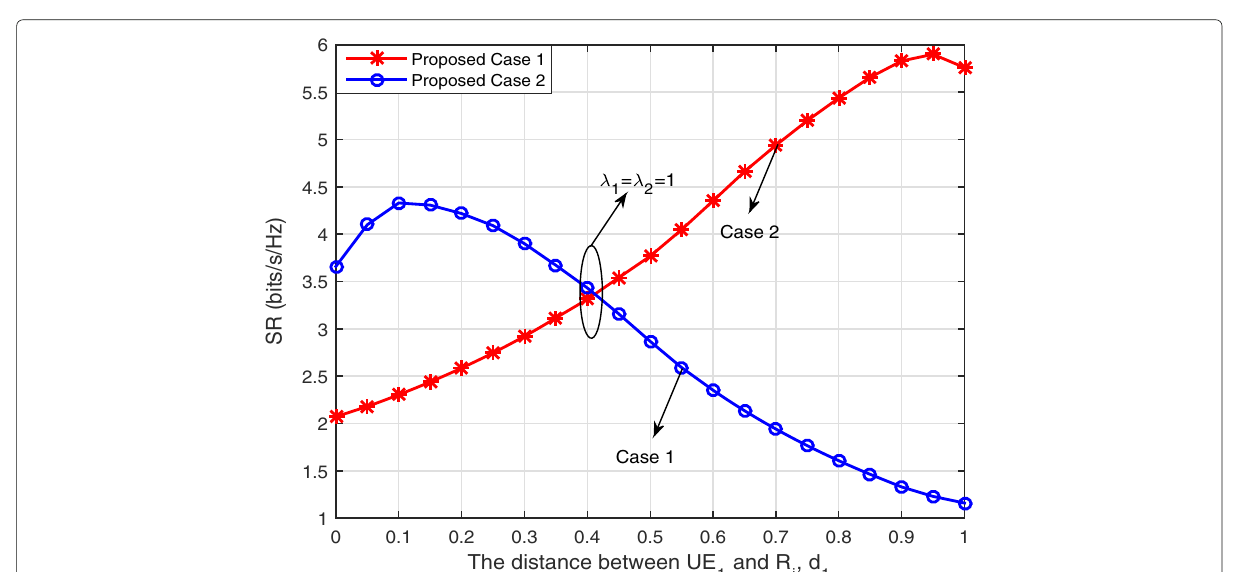
Fig. 5 The achievable weighted SR versus the distance between UE t and R